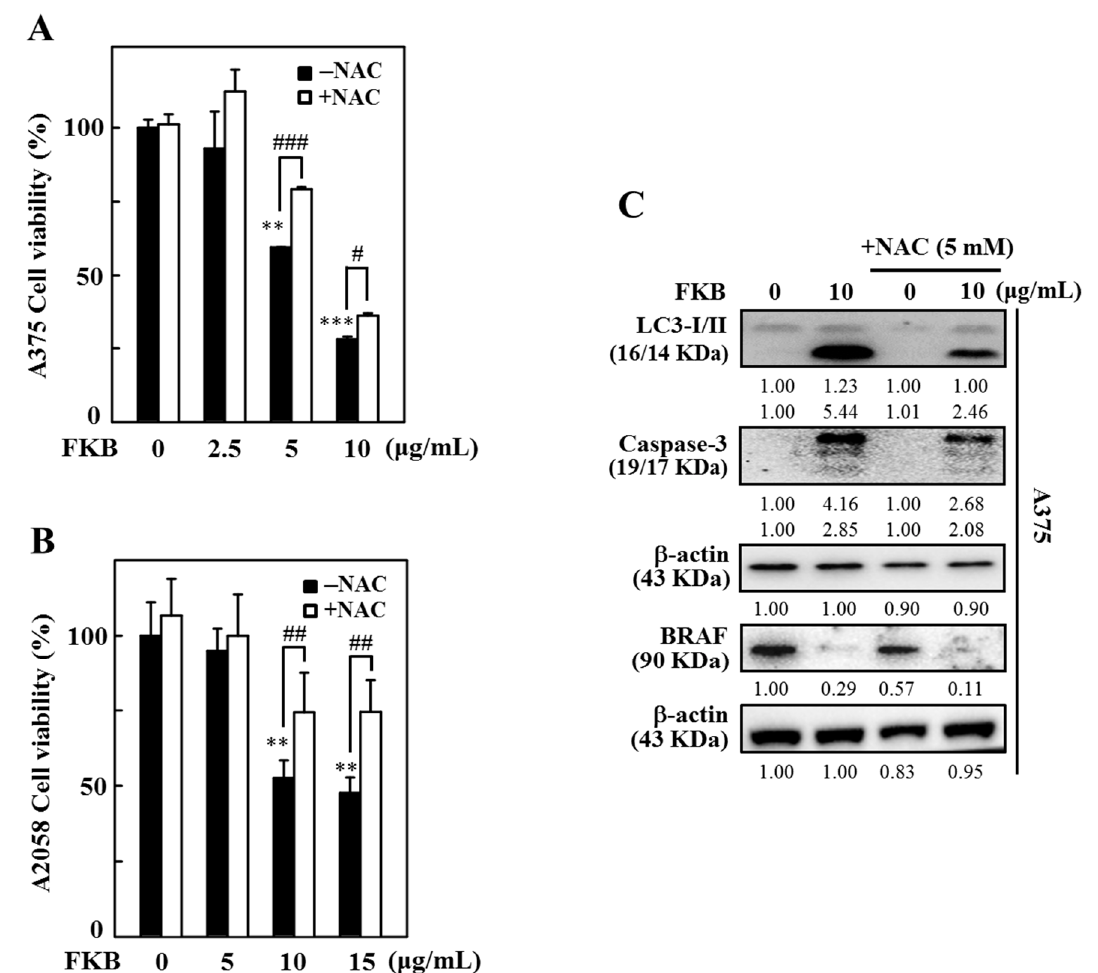
Figure 10. ROS-mediated apoptotic and autophagy cell death in A375 cells was induced due to FKB. A375 and A2058 cells were pretreated with 5 mM NAC for 1 h then followed by treatment with 0–10 and 0–15 µ g / mL of FKB, respectively, for 24 h. ( A , B ) Cells were subjected to MTT assay to measure the percentage of cell viability. ( C ) Western blot was used to measure the expression levels of LC3-I / II, caspase-3, and BRAF proteins both in the absence or presence of NAC pretreatment conditions. β -actin acts as an internal control. Each value was expressed as mean ± standard deviation (SD) of three experiments. Statistical significance was assigned as ** p < 0.01 and *** p < 0.001 compared to untreated control cells. # p < 0.05, ## p < 0.01 and ### p < 0.001 compared to FKB alone treated cells.